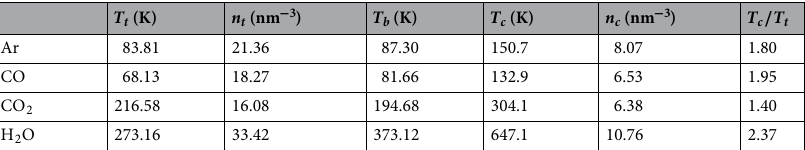
Table 1. Thermophysical data of the four materials: Ar, CO, CO 2 , and water ice. T t and n t : triple-point temperature and number density. T b boiling temperature at 0.1 MPa. T c and n c : critical temperature and number density. Data taken from Refs. 61,62 .